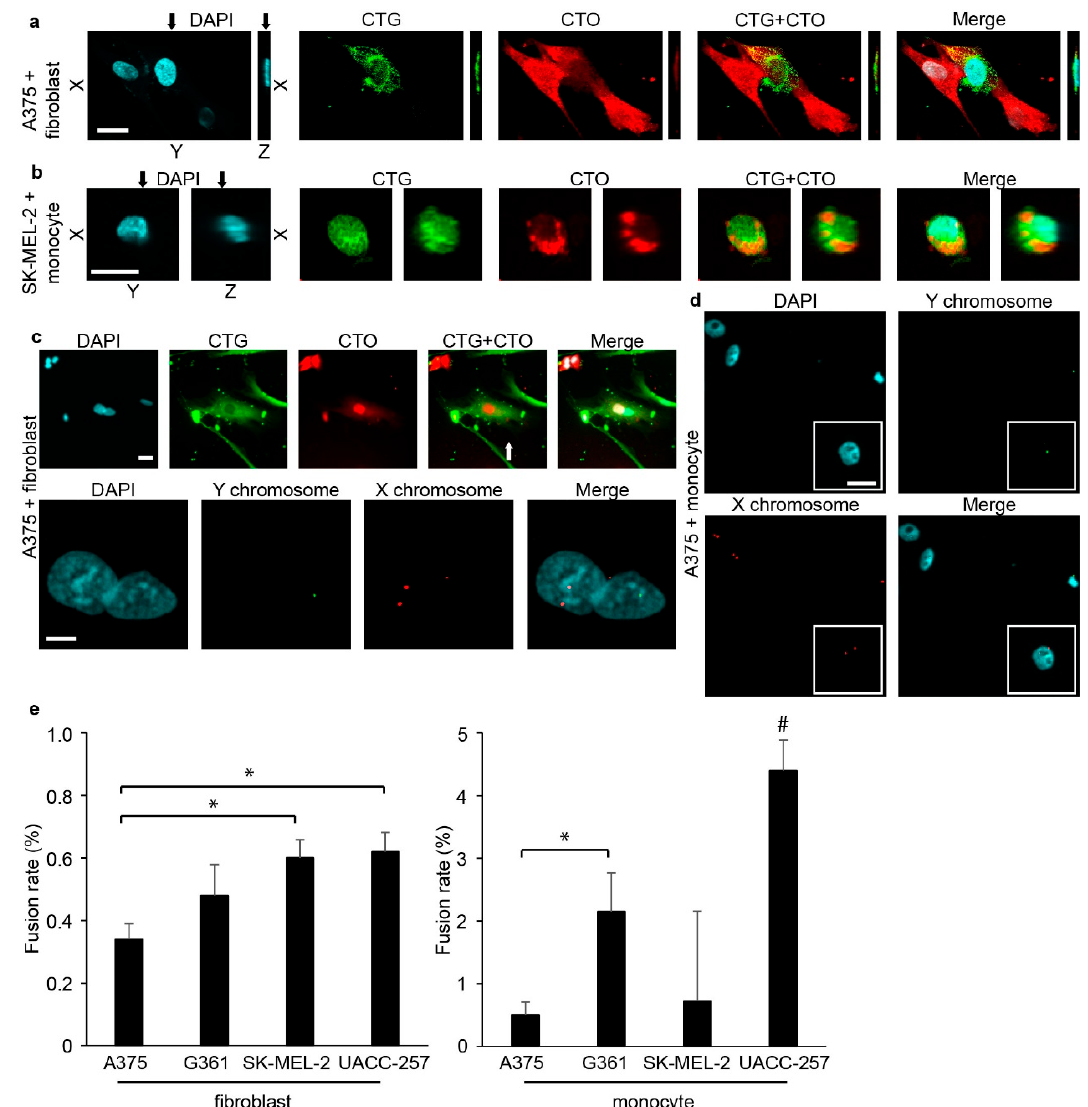
Figure 2. Melanoma cells spontaneously fused with primary human dermal fibroblasts and monocytes. ( a , b ) A melanoma (CTO)–fibroblast (CTG) ( a ) and a melanoma (CTO)–monocyte (CTG) ( b ) hybrid visualized with a confocal microscope in X - Y and X - Z planes. The Z -stacking confirms that double positivity does not result from cells lying on each other. Black arrows indicate the crossline of planes; white bars indicate 20 µ m ( a ) and 10 µ m ( b ). ( c ) A melanoma (CTO)–fibroblast (CTG) hybrid confirmed with confocal microscopy contains a nucleus from a female melanoma cell and another from a fibroblast from a male donor ( upper row ). Fluorescent in situ hybridization visualizing three X (red) and one Y (green) chromosome in the same cell ( lower row ). White bars indicate 30 µ m ( upper row ) and 10 µ m ( lower row ). ( d ) Fluorescent in situ hybridization visualizing two X (red) and one Y (green) chromosome in a melanoma (female)–monocyte (male) hybrid cell. White bar indicates 10 µ m. ( e ) The percentage of hybrid cells compared to the total number of melanoma cells and fibroblasts or to the total number of melanoma cells and monocytes after 24 h of co-culture measured with flow cytometry. All investigated melanoma cell lines fuse spontaneously with human dermal fibroblasts ( left panel ) and peripheral blood-derived monocytes ( right panel ). Means of three experiments + SD are shown. * indicates significant differences between the marked groups. # indicates a significant difference between the marked group and all the other groups. p < 0.05. DAPI: 4 ′ ,6-Diamidin-2- phenylindol.